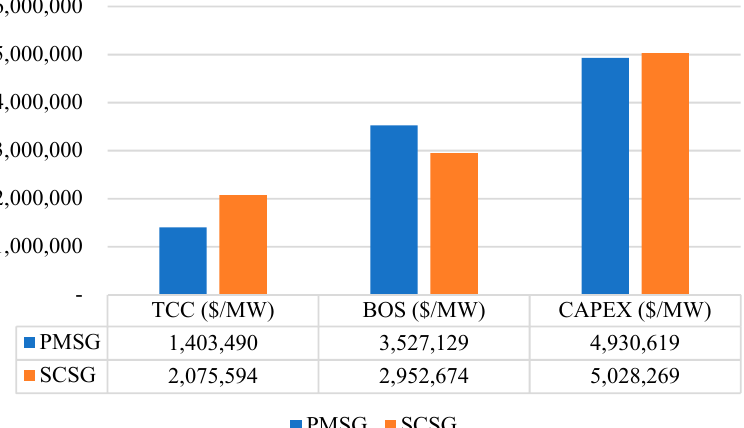
Figure 6. The CAPEX of the PMSG and SCSG type FOWTs.